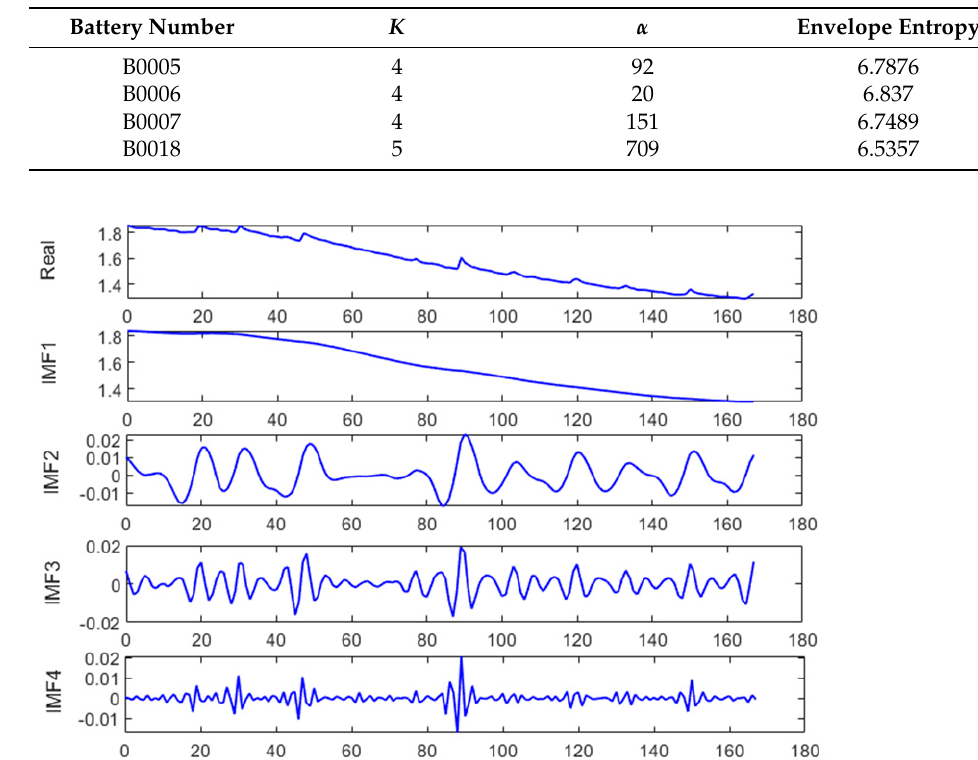
Table 2. Results of the optimization of VMD parameters by the WOA.